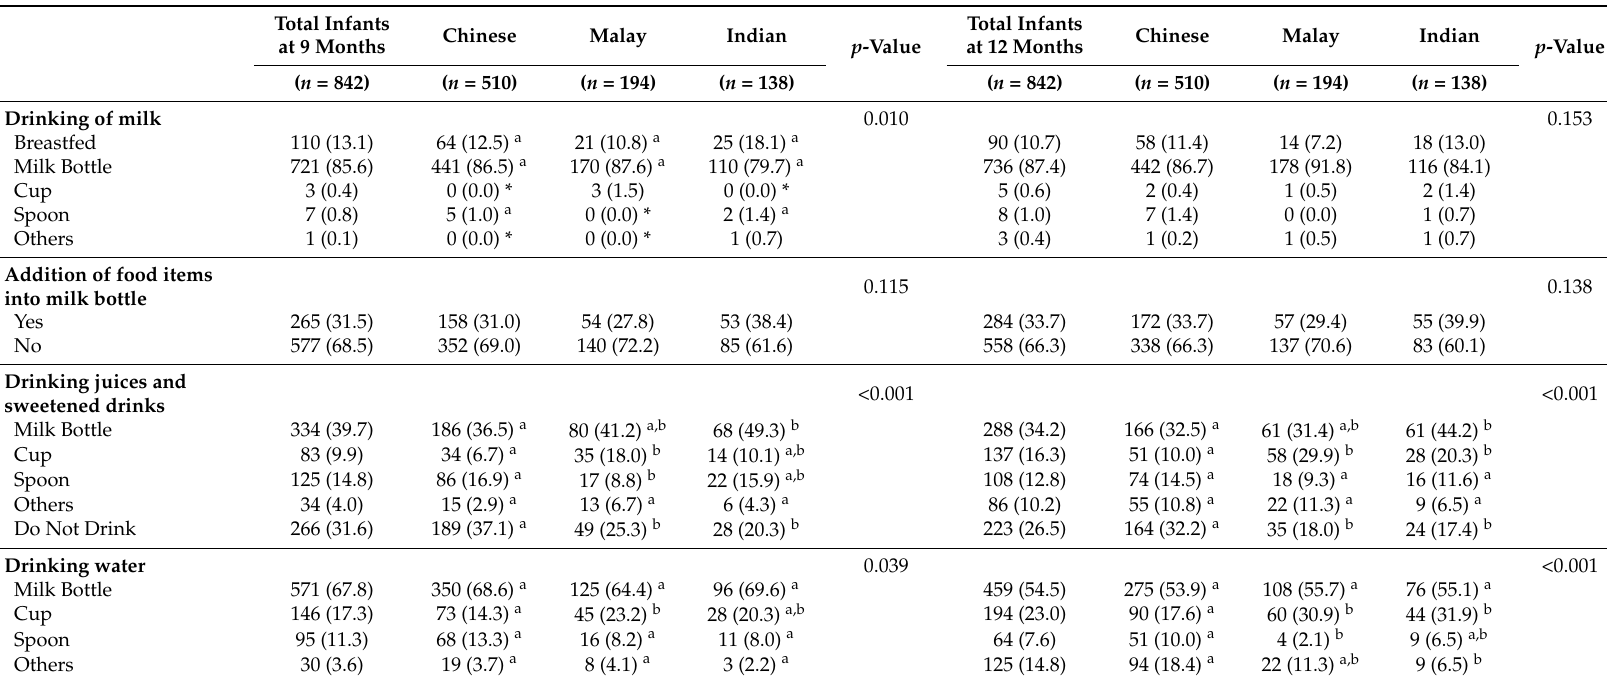
Table 4. Comparison of drinking practices at 9- and 12-month time points among Chinese, Malay and Indian infants ( n